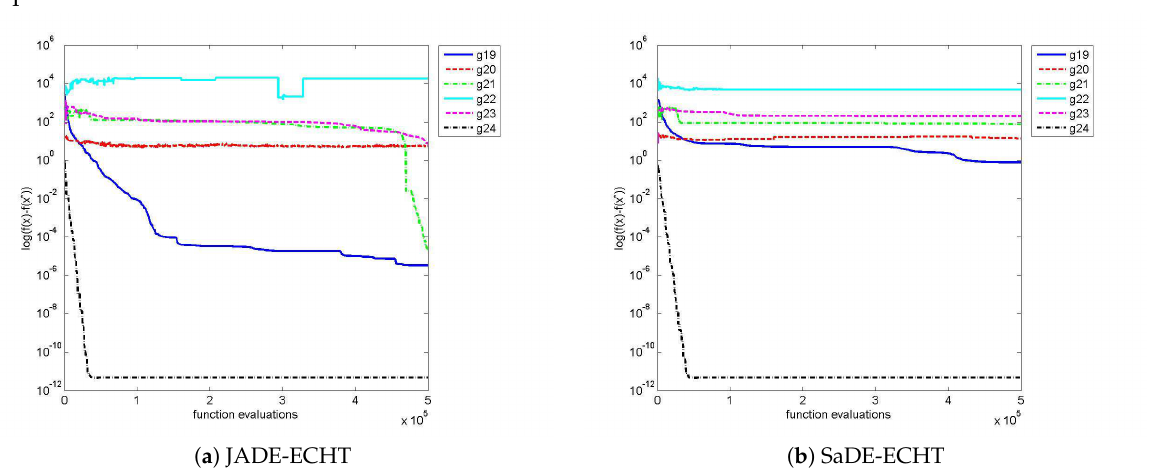
Figure 9. Convergence comparison of JADE-ECHT and SaDE-ECHT for g19–g24.